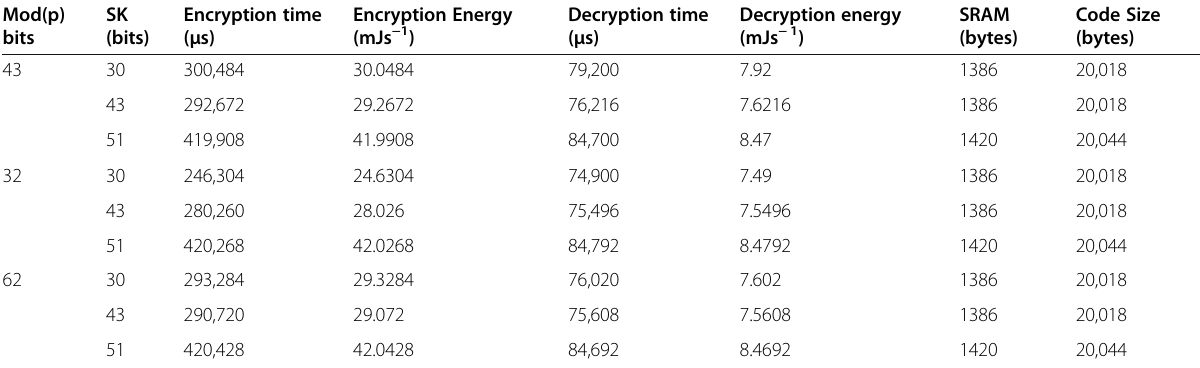
Table 4 Computational and memory performance of the proposed technique Mod(p) bits